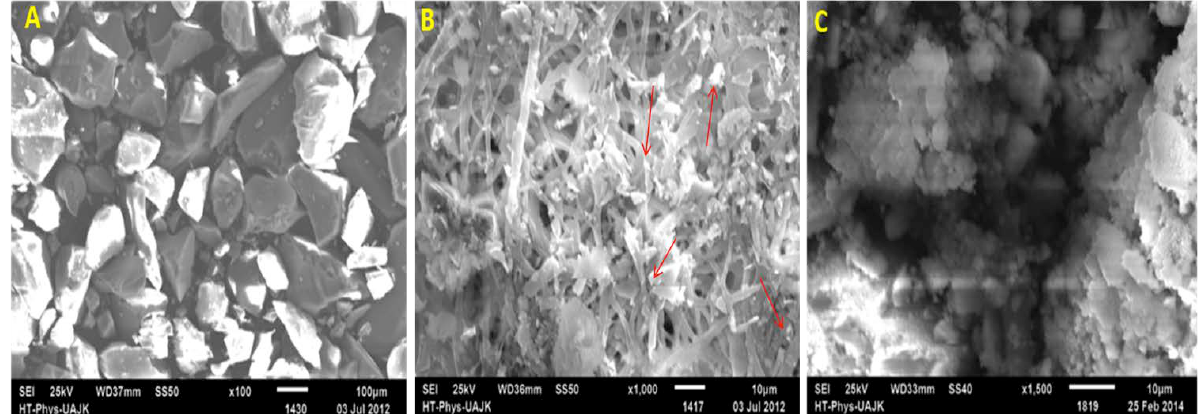
Figure 4: SEM images of immobilization of eggshells powder with P. aeruginosa . (A) egg shells powder, (B) rod like immobilized P. aeruginosa covering eggshells surface and (C) immobilized P. aeruginosa on eggshells powder with adsorbed